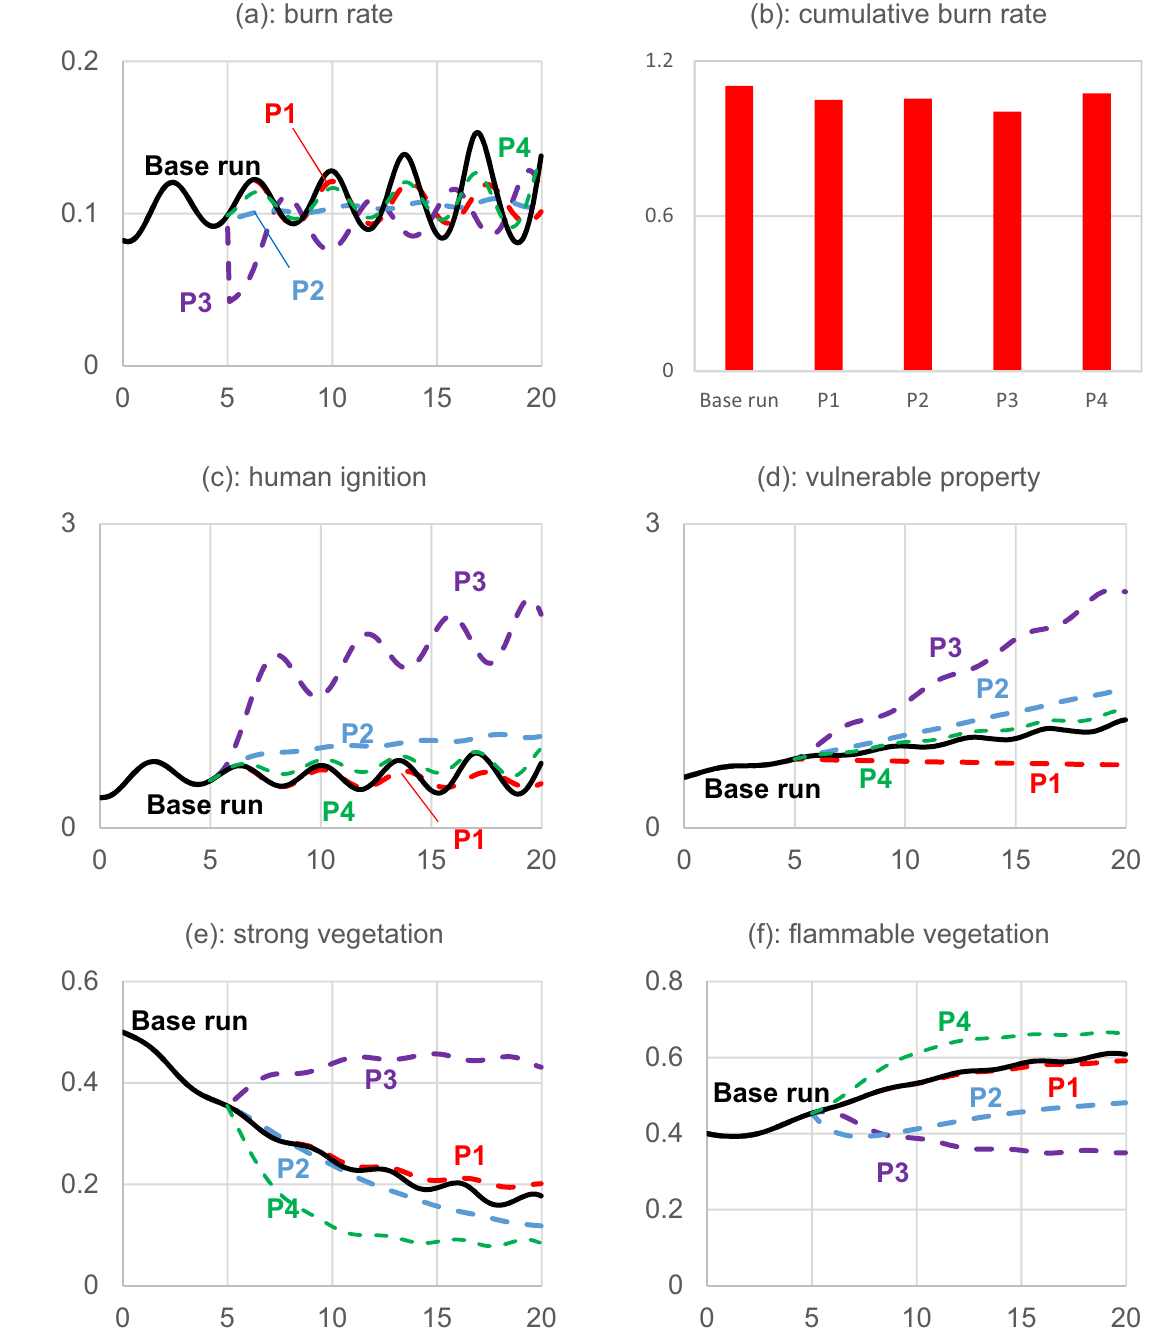
Figure 8. Policy implementation. Note: P1: limits vulnerable property development; P2: prescribed burning; P3: effective firefighting; and P4: Clear cutting. Human ignition unit is Ignition/year, and vulnerable property unit is a million hectares. Strong vegetation and flammable vegetation are provided as the ratio that each occupied the forest